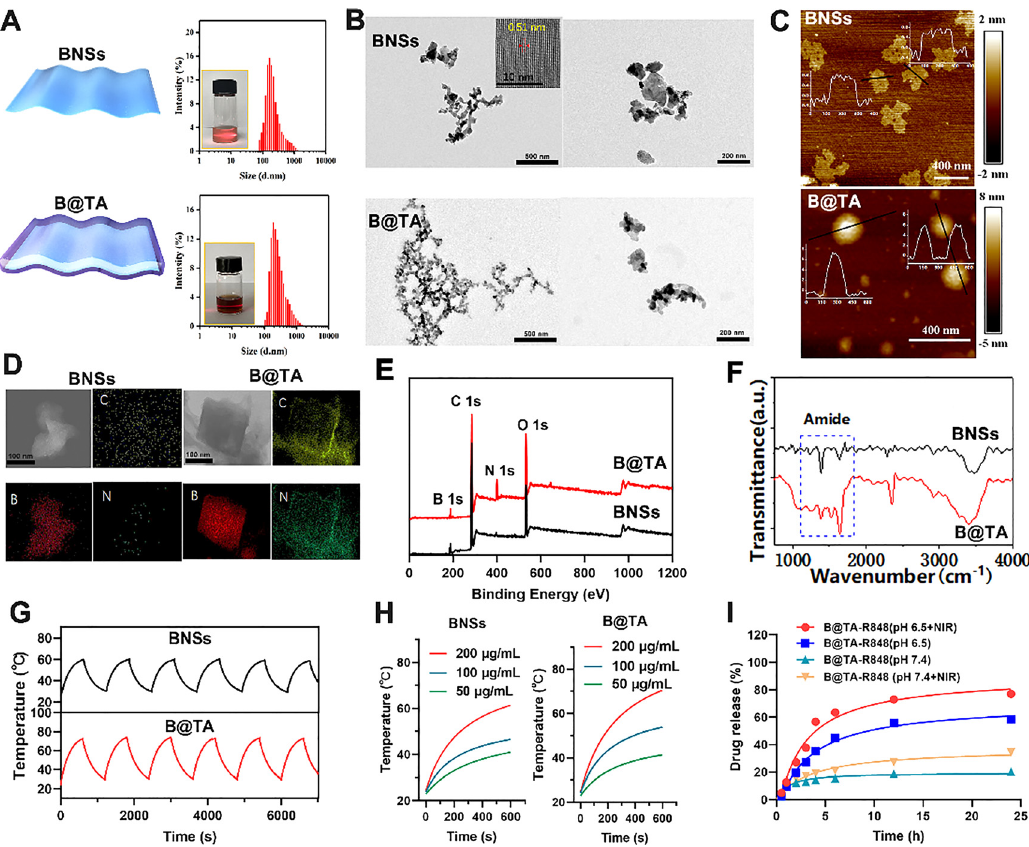
Figure 2: Preparation and characterization of BNSs and B@TA. (A) Size, dispersity, and photo images of BNSs and B@TA; (B) TEM image of BNSs and B@TA (inset: HRTEM image of BNSs. The scale bars represent 500 and 200 nm, respectively. The scale bar of HRTEM represents 10 nm); (C) AFM image of BNSs and B@TA; (D) The element mapping images of BNSs and B@TA (The scale bars represent 100 nm). (E) XPS spectra of BNSs and B@T; (F) FTIR spectra of BNSs and B@TA; (G) Photothermal conversion stability of BNSs and B@TA. The laser was turned on for 10 min and then turned off for each cycle. The concentrationofBNSsandB@TAare200 μ gmL − 1 andthelaserpowerdensityis2Wcm − 2 ;(H)PhotothermalheatingcurvesofBNSsandB@TA at different concentrations under 808 nm laser irradiation (2 W cm − 2 ) for 10 min; (I) Release pro fi les of R848 at different conditions with or without 808 nm NIR laser (2 W cm − 2